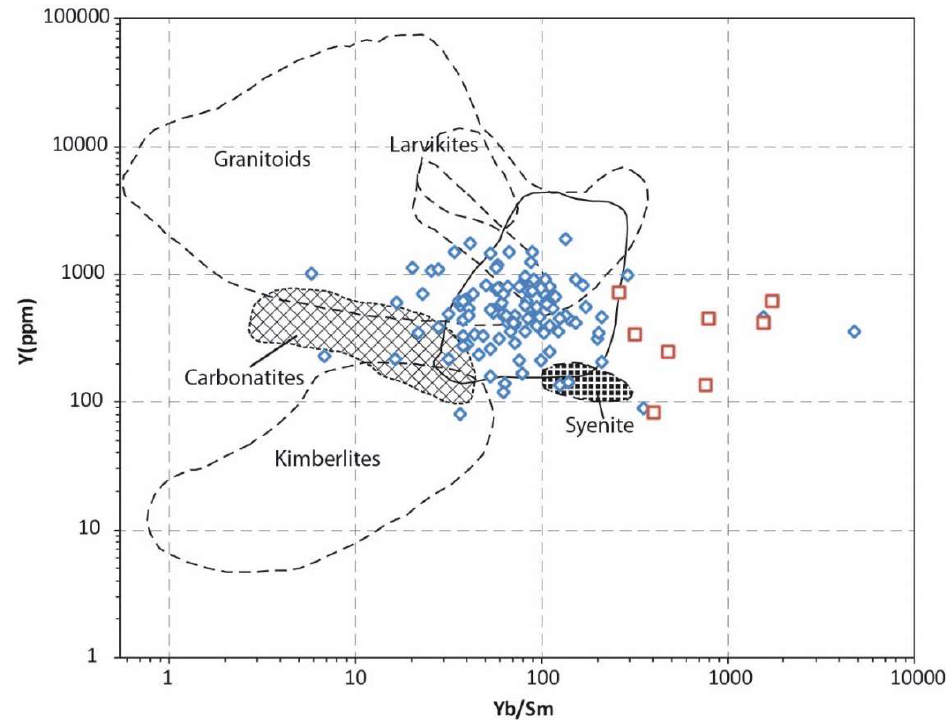
Figure 9. Y versus Y/Sm plot of western Meiganga magmatic zircons (adapted from [19,54], blue and white diamond-shape plots are for magmatic zircons; red and white square plots are for metamorphic zircon).